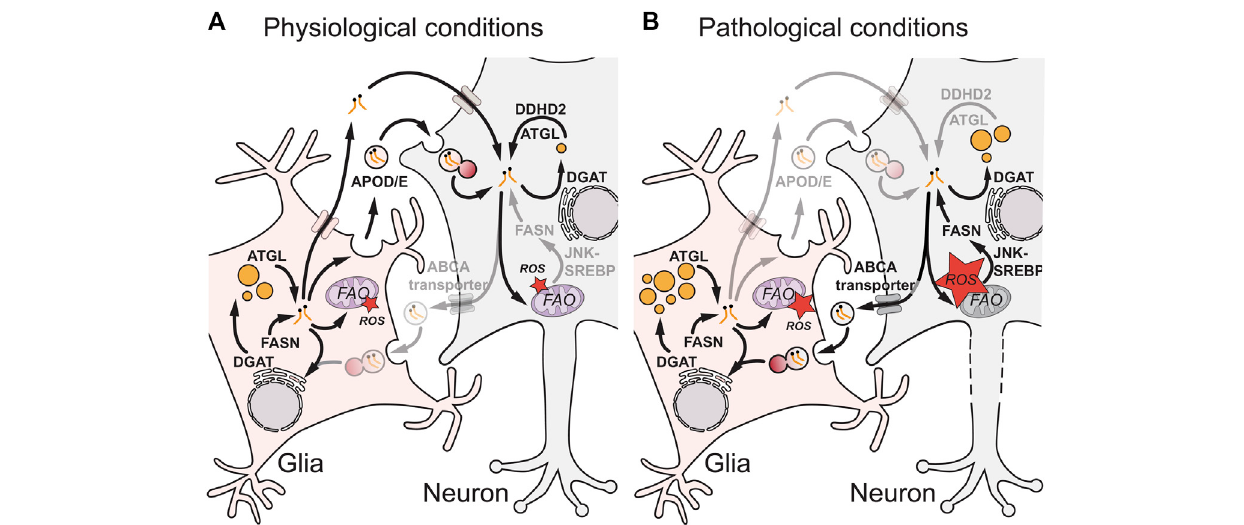
FIGURE 2 | Glial-neuronal lipid transfer during physiological and pathological conditions. During physiological conditions (A) , the exchange of lipids between glia and neurons is mediated by apolipoprotein D/E (APOD/E) particles or other protein carriers such as albumin. In glia, fatty acids generated by fatty acid synthase (FASN) and converted into triacylglycerols (TAGs) via diacylglycerol acyltransferase (DGAT) can be remobilized from lipid droplets (LDs) by adipose triglyceride lipase (ATGL) for transfer to neurons or to enter mitochondria for fatty acid oxidation (FAO). In neurons, ATGL and DDHD Domain-Containing 2 (DDHD2) ensure that TAG lipolysis approximatelymatchesTAGsynthesis,preventingLDaccumulationandensuringtheFAsupplyforneuronalfunctionssuchasmembranesynthesis.Underpathological conditions (B) , mitochondrial dysfunction in neurons is associated with high reactive oxygen species (ROS) that trigger c-Jun N-terminal Kinase (JNK) and sterol regulatory element-binding protein (SREBP) signalling, which increases FASN synthesis of FAs and in some circumstances leads to ectopic neuronal LDs. Excess neuronalFAsaresecretedfromneurons via ATP-bindingcassette(ABC)AtransportersandAPOD/Eparticles,takenupbyglia via endocytosisandtraf fi ckedthroughthe endolysosomal pathway and ER via DGAT into glial LDs. Glial LDs may protect against lipotoxicity and high reactive oxygen species (ROS) via multiple non-mutually exclusive mechanisms ( Figure 1B ). In neurons during pathological conditions, altered TAG metabolism and ectopic LDs may contribute to dysfunction and neurodegeneration (axonal dotted line).